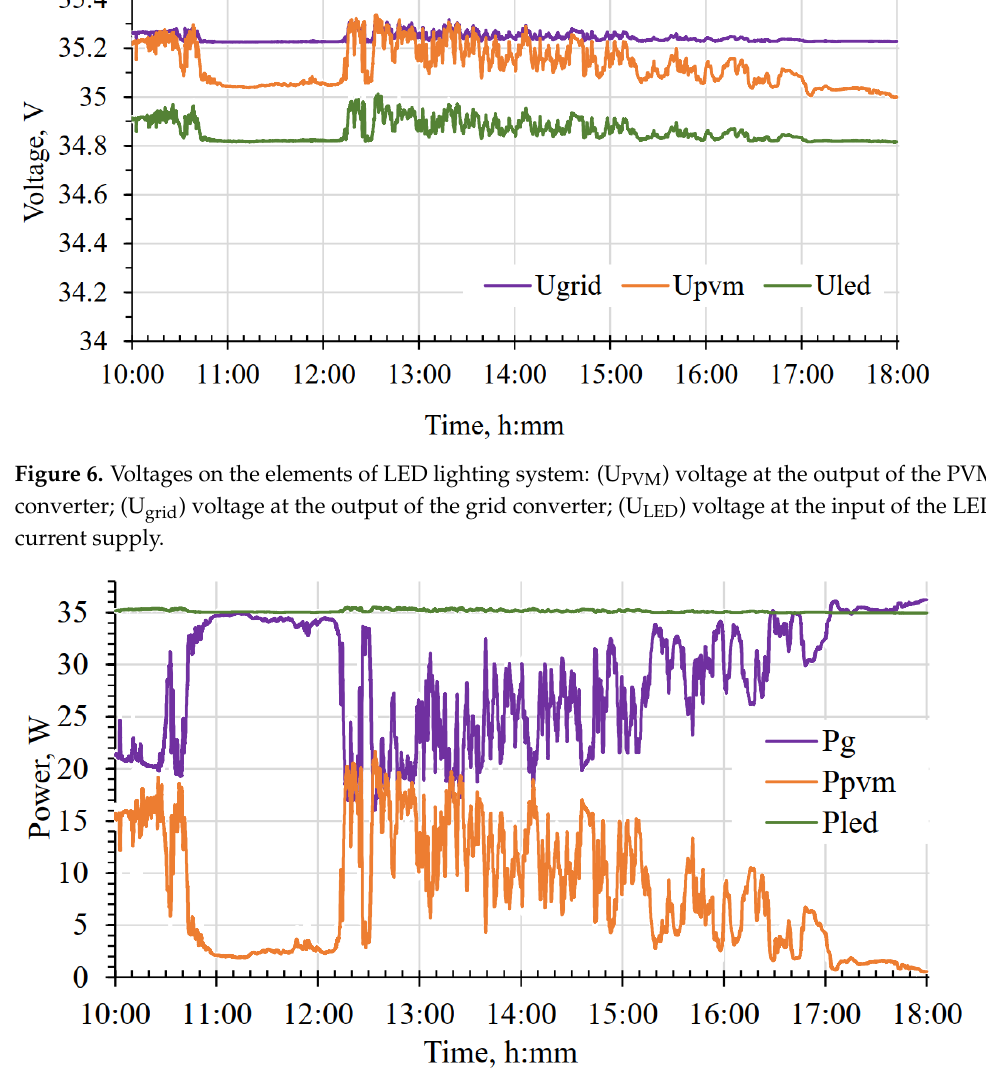
Figure 7. Power indicators of the lighting system elements: (P LED ) LED power; (P PVM ) power at the output of the PVM converter; (P G ) power at the output of the network